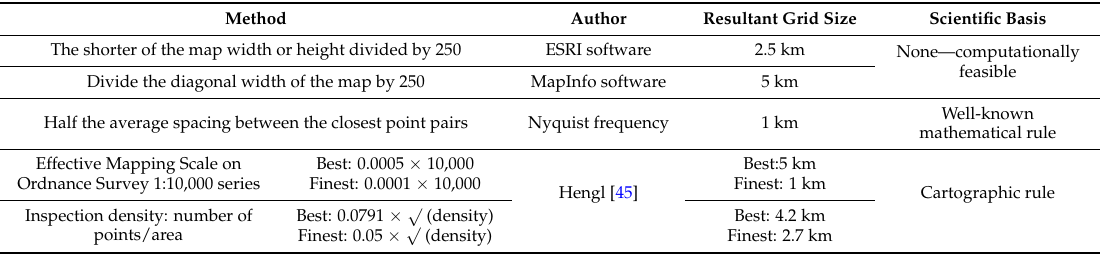
Table 2. Results of five methods of Selection of Grid Resolution. ESRI: Environmental Systems Research